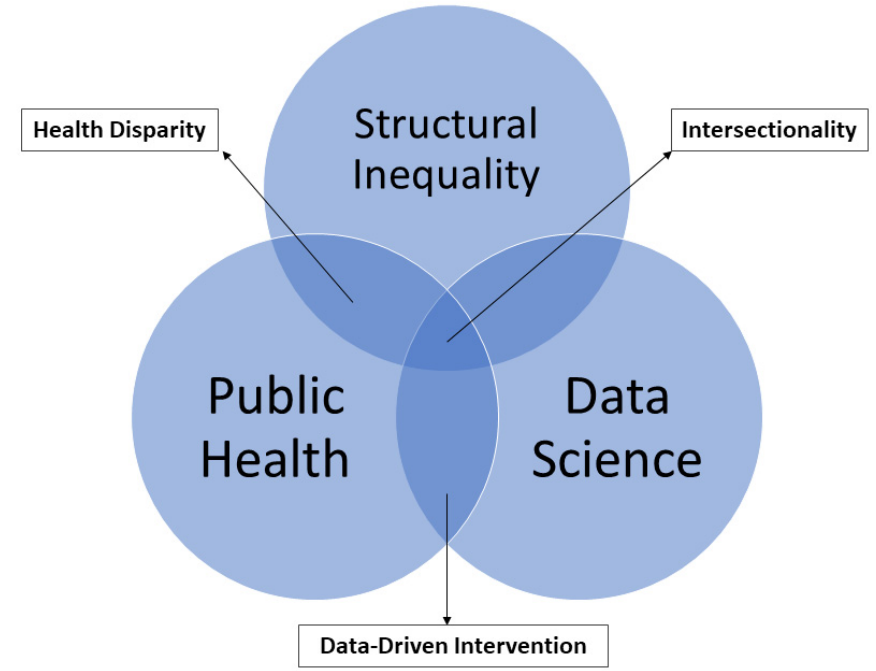
Figure 2. The intersection between structural inequality, public health, and data science.